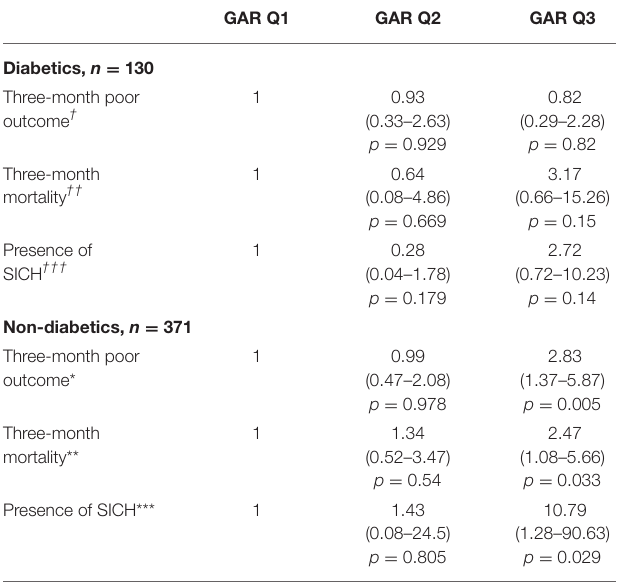
TABLE 3 | Logistic regression model: adjusted ORs (95% CIs) of the GAR tertiles in relation to the respective primary outcome measures in 130 diabetic patients and in 371 non–diabetic